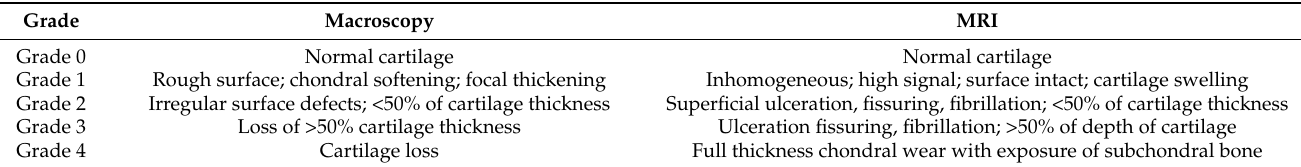
Table 1. Outerbridge classification